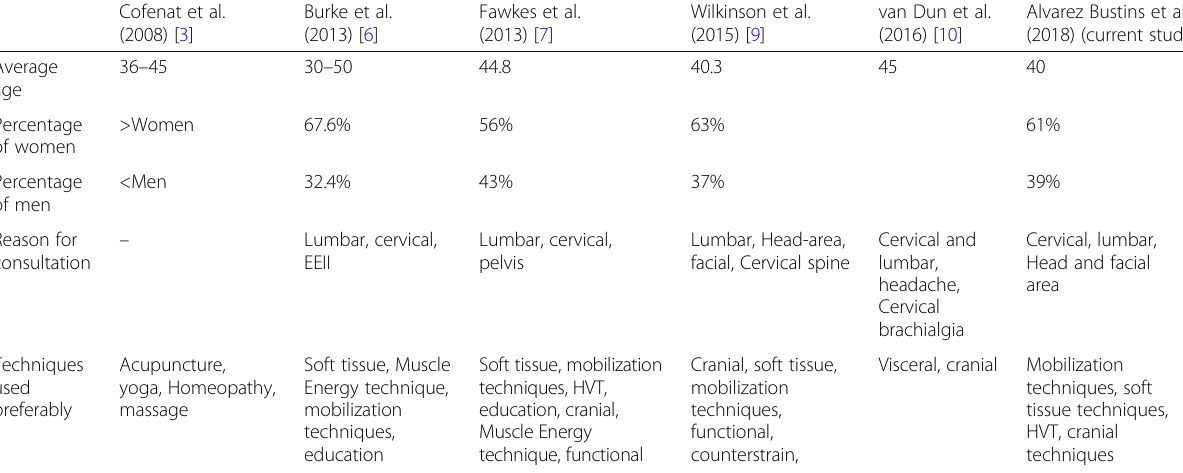
Table 7 Patients data compared to available literature